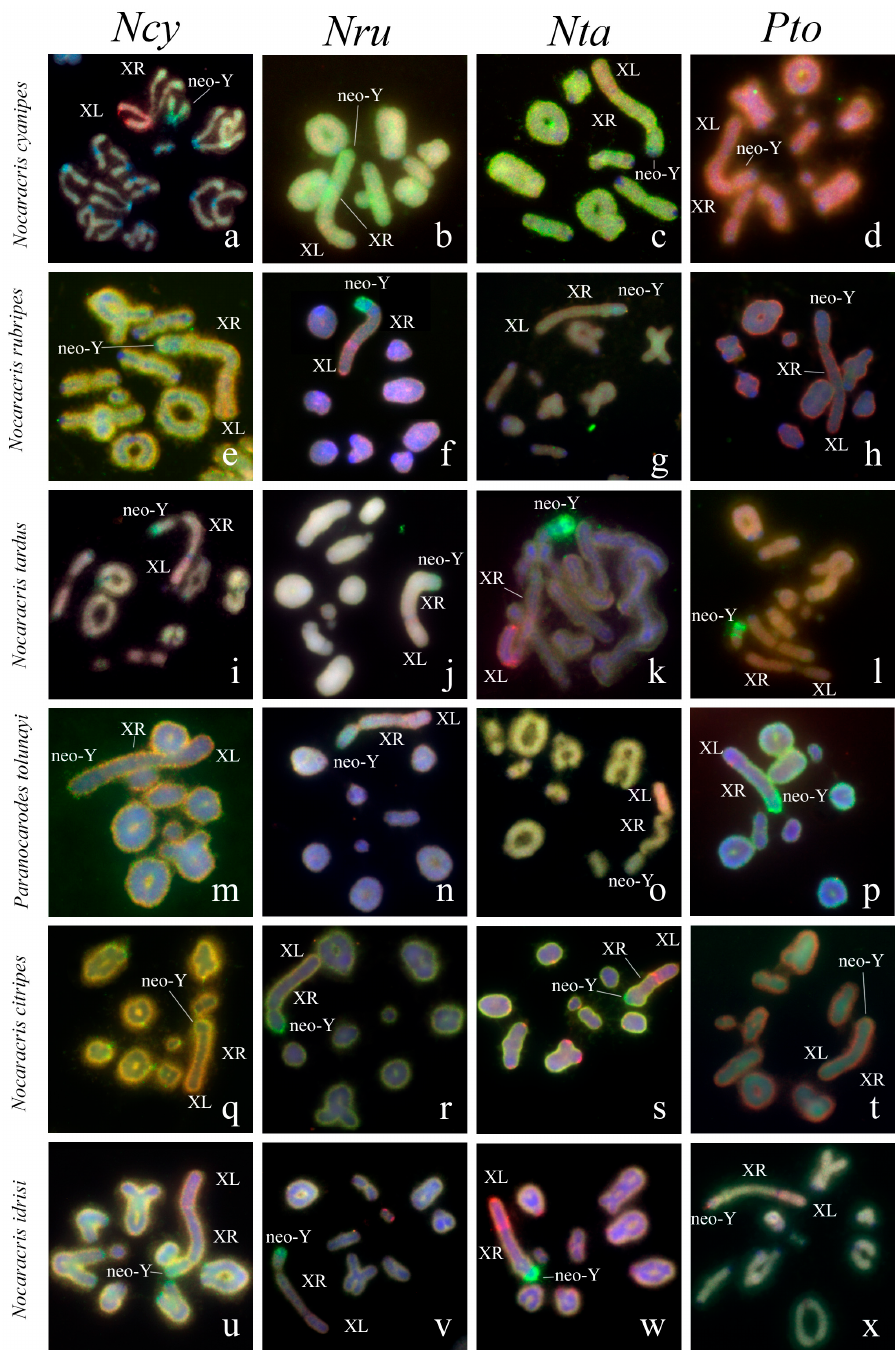
Figure 3. FISH of microdissected DNA probes with meiotic chromosomes of Nocarodeini species: the XL DNA probes (red) and the neo-Y DNA probes (green). XL indicates short arm of neo-X that corresponds to ancestral X chromosome, XR indicates long arm of neo-X chromosome derived from autosome fusion. Neo-Y indicates corresponding chromosome. Names of species indicated in rows and name of probes indicated in columns. ( a – d ) Nocaracris cyanipes ; ( e – h ) Nocaracris rubripes ; ( i – l ) Nocaracris tardus; ( m – p ) Paranocarodes tolunayi tolunayi ; ( q – t ) Nocaracris citripes citripes; ( u – x ) Nocaracris Idrisi ; ( a,c,e,g,i,k,q,s,u,w ) Intensive FISH signals from neo sex chromosome probes can be observed in C-positive regions of autosomes.